Question: Condense the content of this figure into a single sentence.
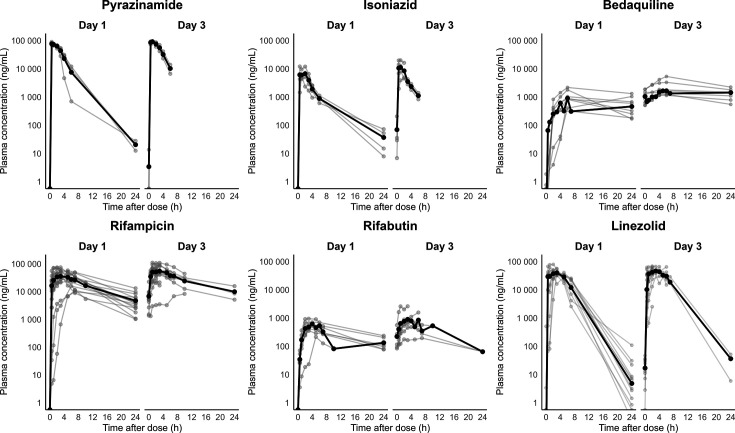
Answer: Dosing regimens and corresponding human-equivalent doses for each experiment